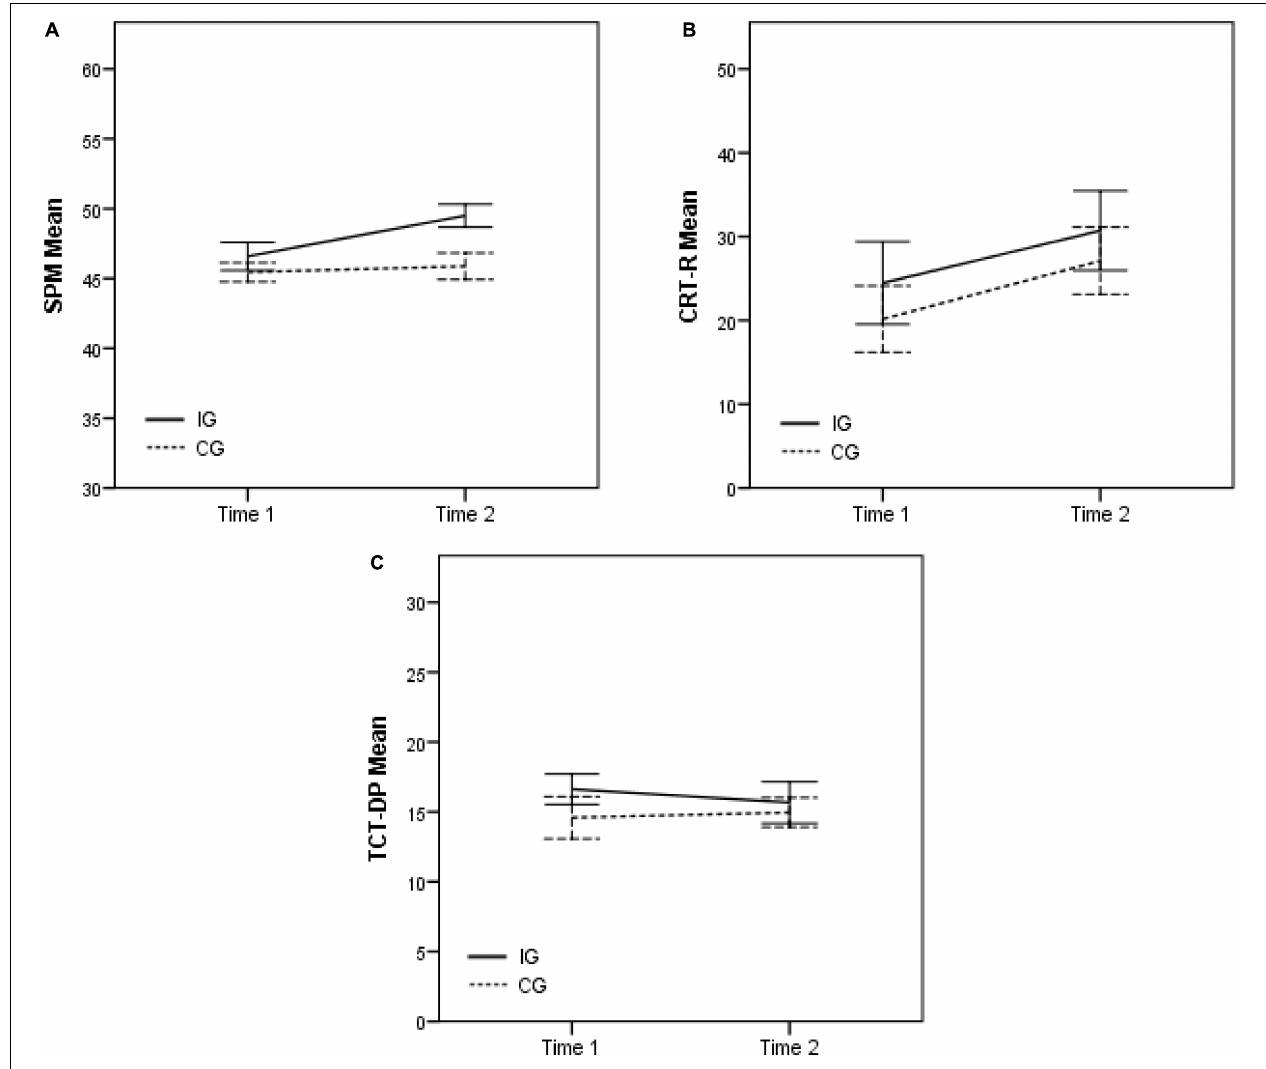
FIGURE 1 | Means of the raw scores of the SPM (A) , CRT-R (B) , and TCT-DP (C) of IG and CG in T1 and